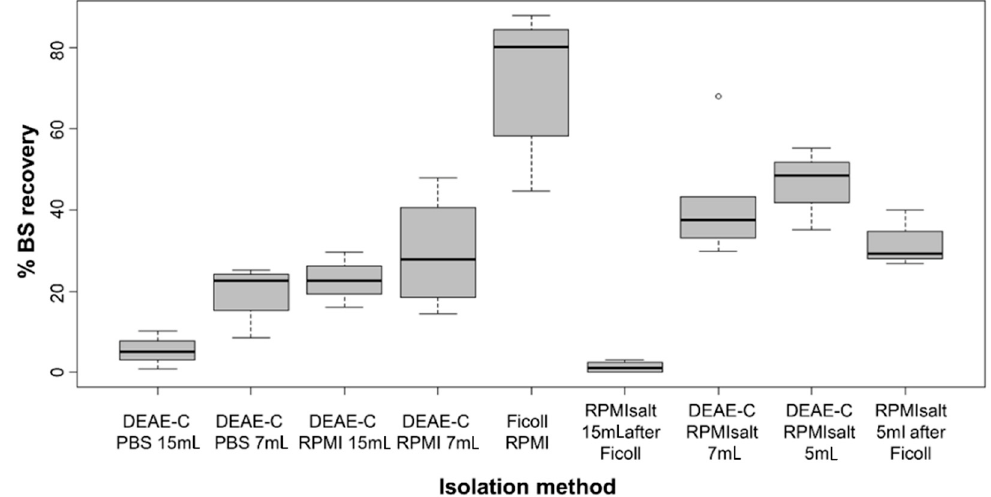
Figure 1. Comparison of S. molnari BS yields from different DEAE-C/Ficoll isolation protocols, using carp full blood as the starting material. Black horizontal lines represent the median, boxes represent 50% of the values, and upper and lower whiskers represent values >75th and <25th percentiles. Data based on blood samples of 3–8 fish each. ° represents an outlier.